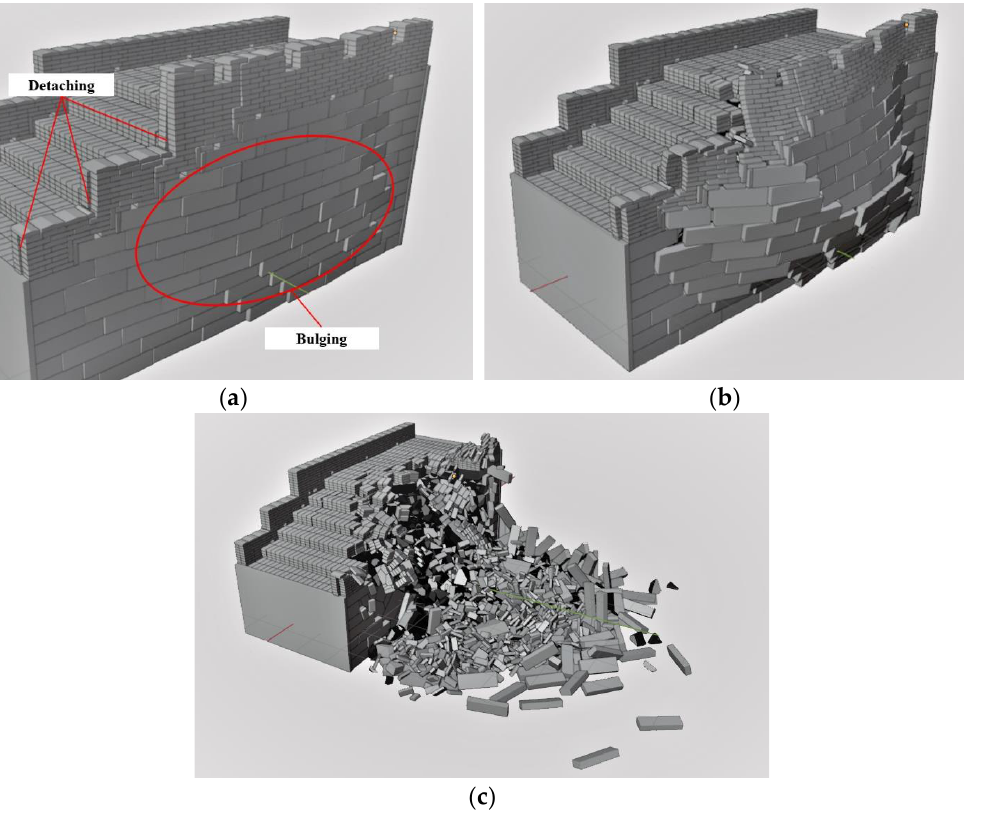
Figure 22. Stone layer bulge with wythe detachment: ( a ) Initial; ( b ) In progress; ( c ) Final.